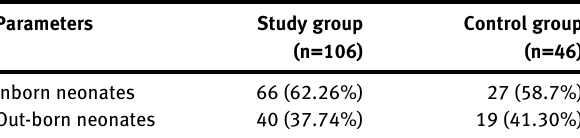
Table  : Birth parameters between study and control group population.